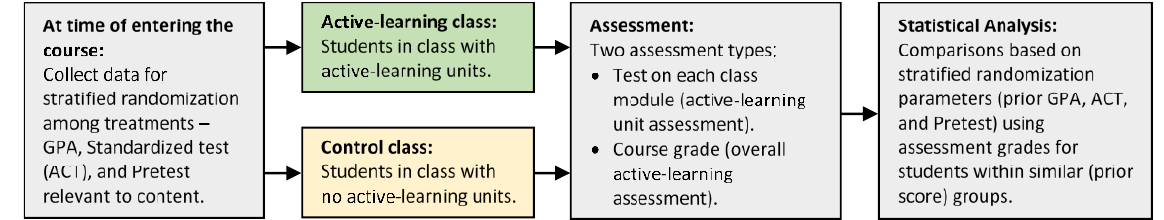
Fig. 2. Approach and experimental design for the research on the effect of active-learning on nuclear skill-set